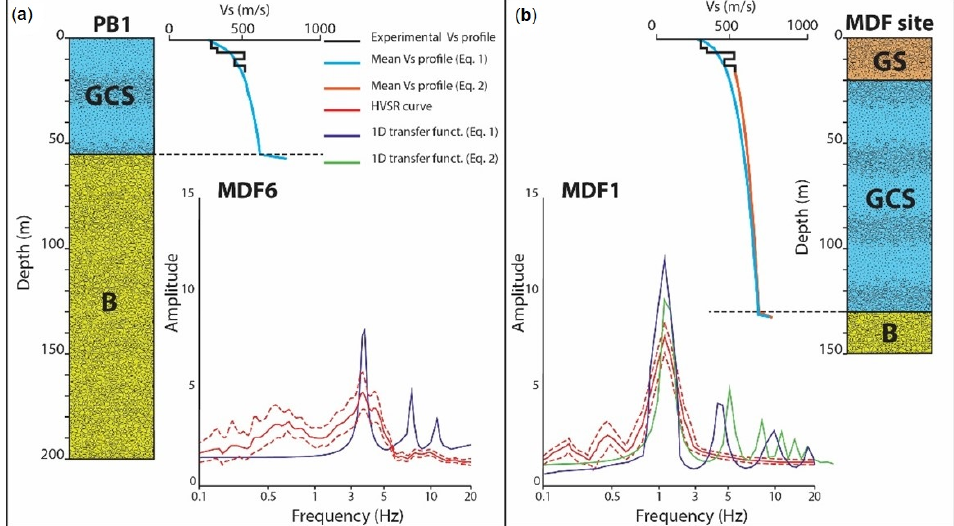
Figure 15. 1D numerical model schemes adopted for the computation of the elastic transfer functions at PB1 boreholes ( a ) and the MDF site ( b ) and comparison with the HVSR curve obtained from adjacent microtremor measurements (MDF6 in a and MDF1 in b ) GS: gravel and sand; GCS: gravel, conglomerate and sand; B: breccia (seismic bedrock).